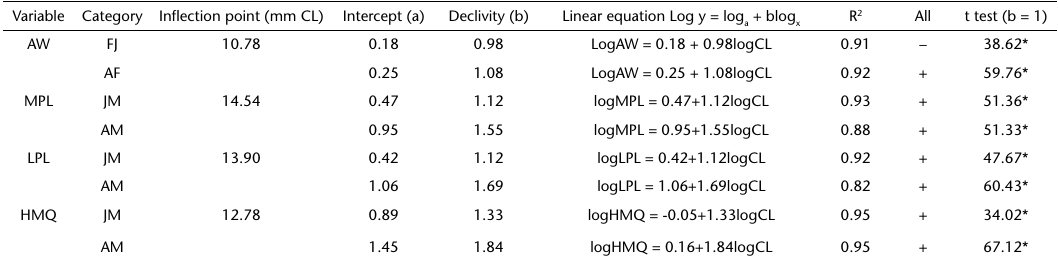
Table 1. Allometric relationships of the populations of Aegla georginae in the PerauCreek, Ibicuí Basin, Brazil. (JM) Juvenile males, (AM) adult males, (JF) juvenile females, (AF) adult females, (CL) cephalothorax length, (AW) second abdominal somite width, (MPL) minor propodus length, (LPL) larger propodus length, (HMQ) height of major chela, (+) positive allometry, (−) negative allometry, (*) significant.